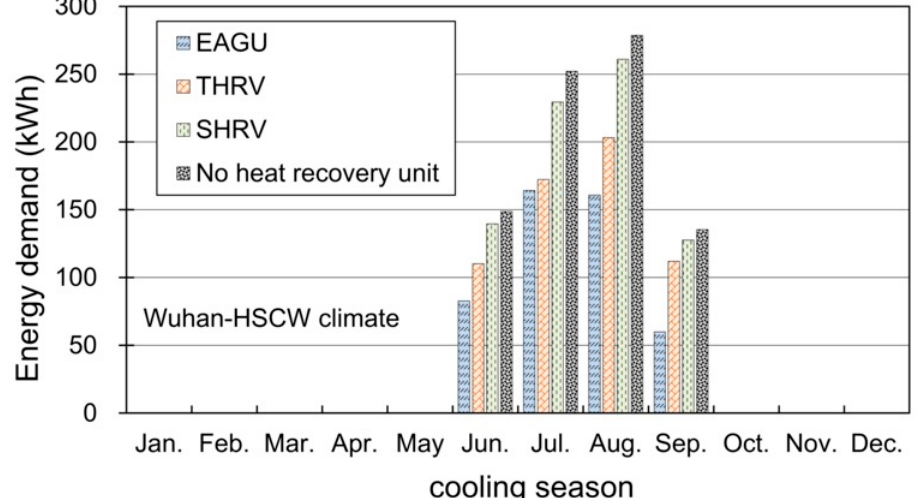
Figure 7. Monthly energy demand of the four cases in the cooling season.